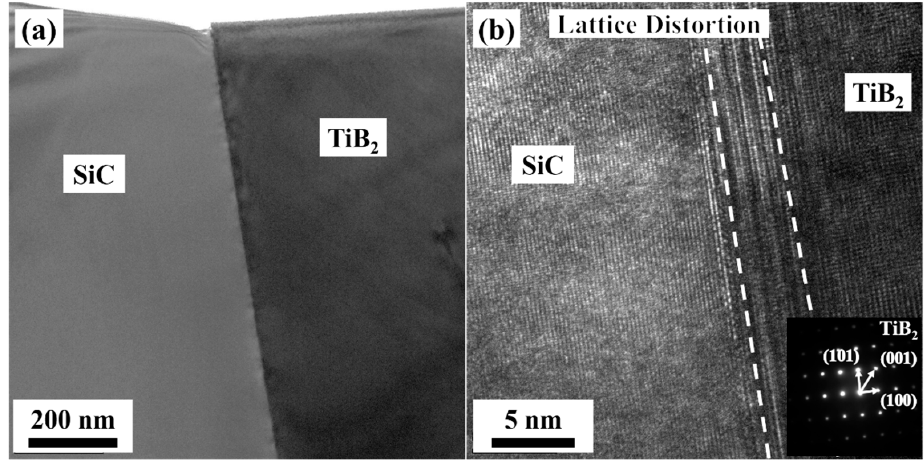
Figure 9. Interface structure between B 4 C and TiB 2 . ( a ) Bright field TEM image, ( b ) HRTEM image.